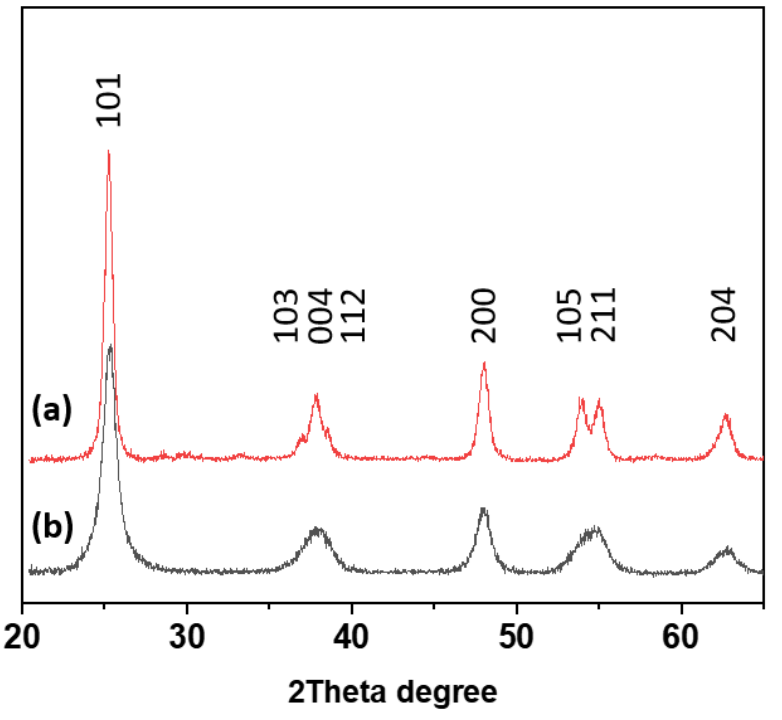
Figure 1. Powder X-ray diffraction patterns of ( a ) Ti-600 and ( b ) UV100. The patterns are indexed according to JCPDS Card no. 00-021-1272 for anatase TiO 2 .